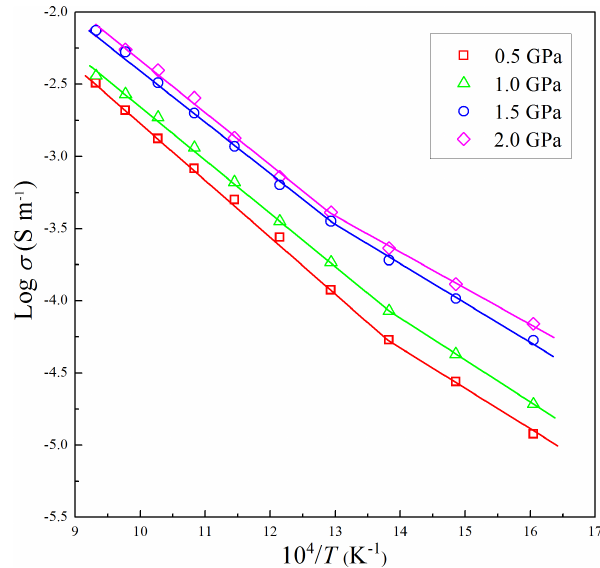
Figure 5. Logarithm of the electrical conductivities versus the re- ciprocal temperatures for run DS12 gneiss during two heating and cooling cycles at 1.5GPa.